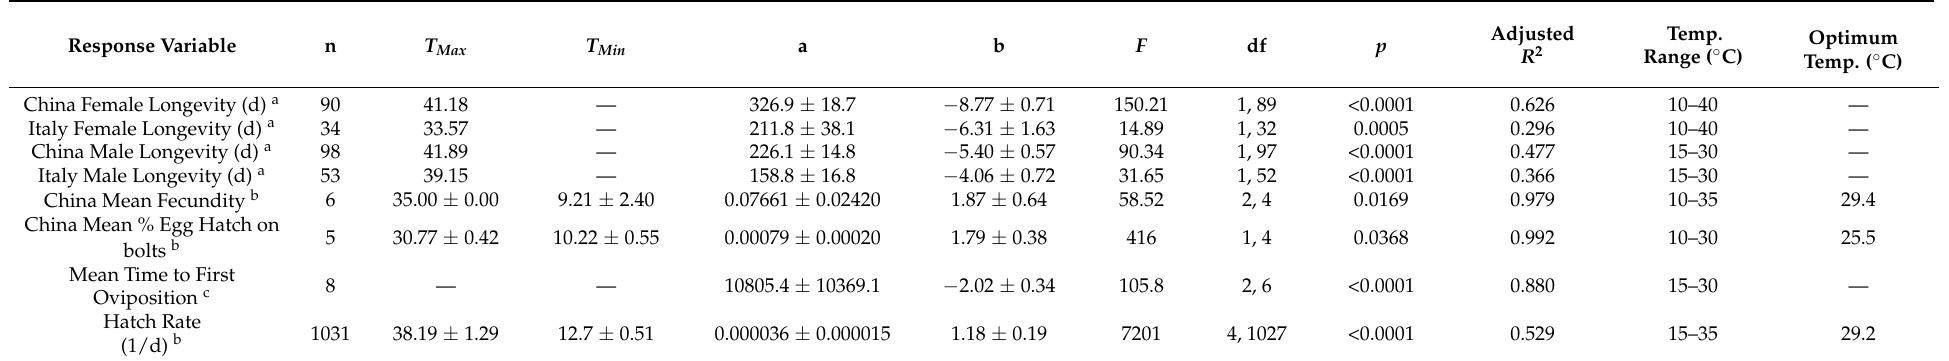
Table 2. Parameter values for linear and non-linear models were used to describe the relationships between temperature and selected life-history values for Anoplophora